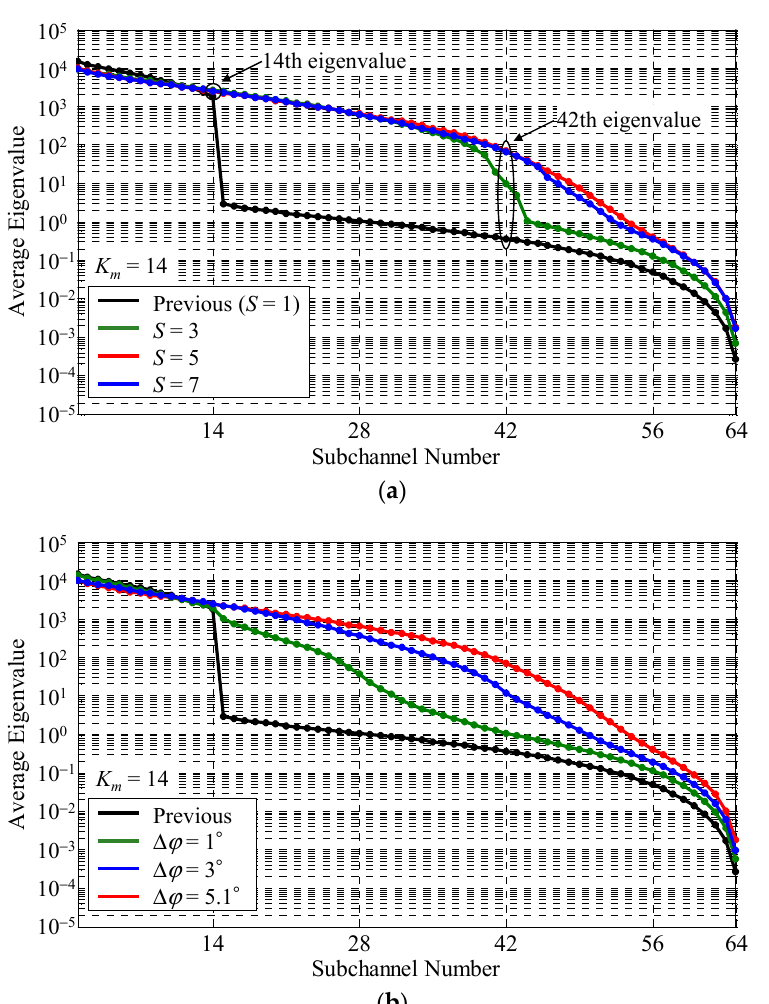
Figure 7. Eigenvalue distribution: ( a ) with the number of scatterer sets as a parameter; ( b ) with the rotation angle increment as a parameter.